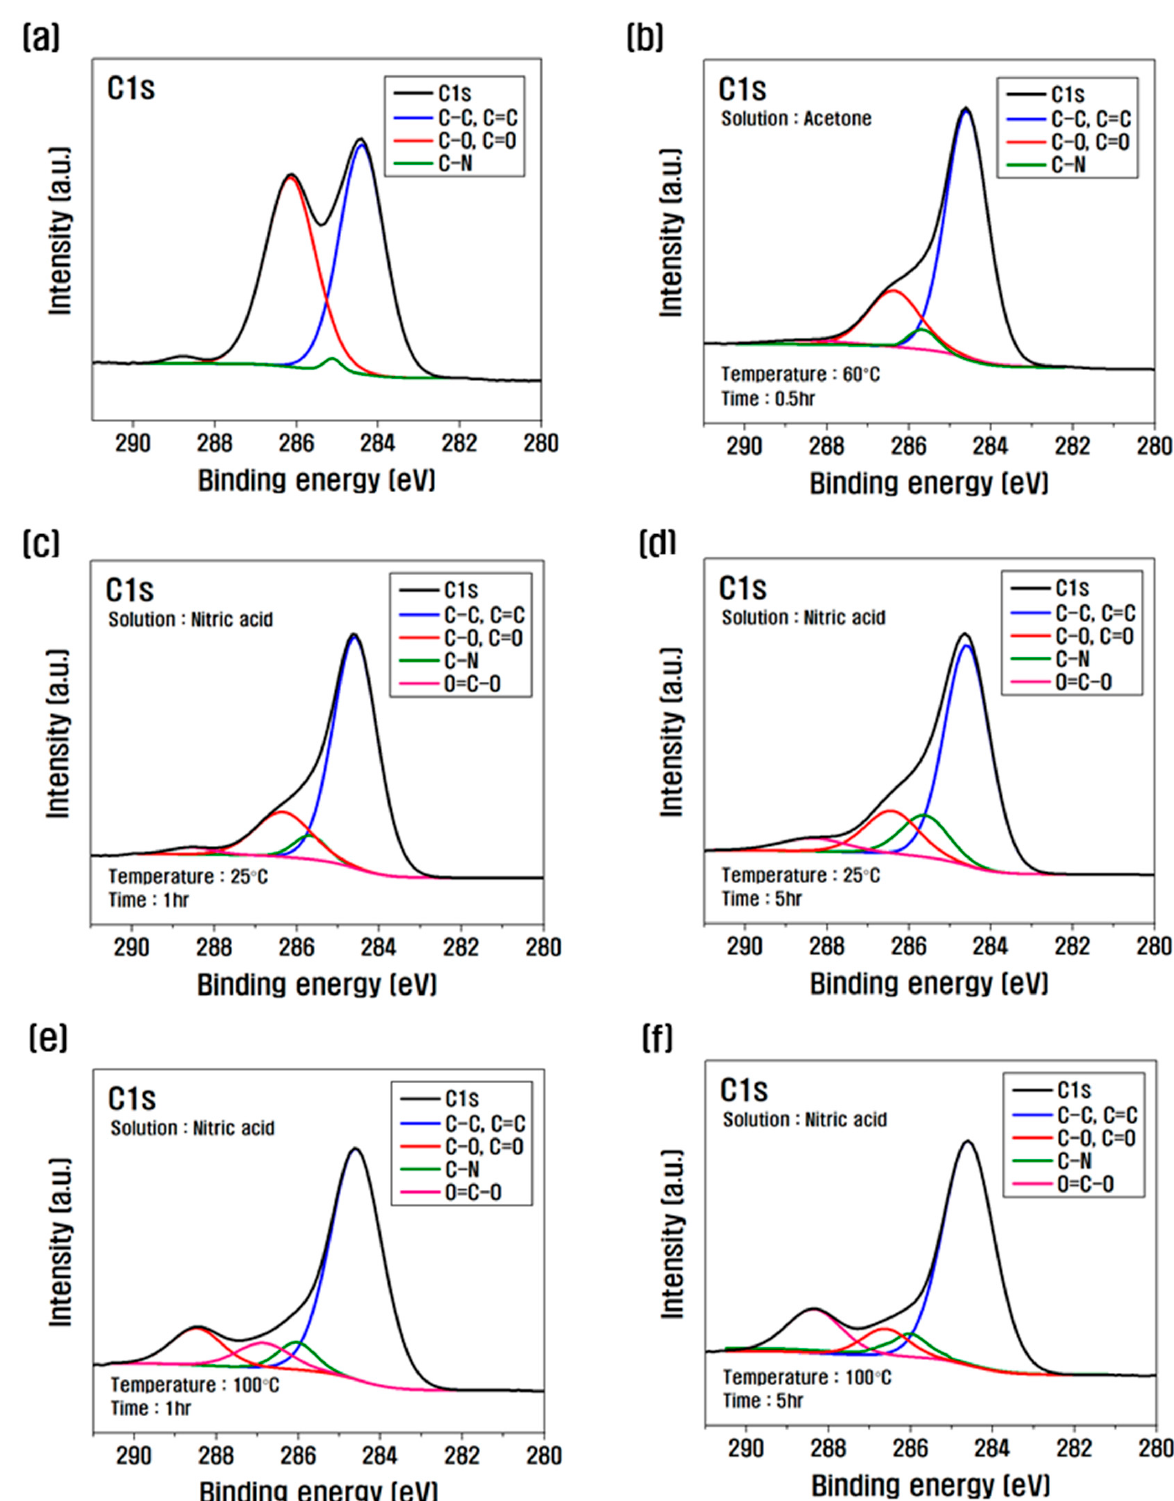
Figure 4. XPS photoelectron spectra of C1s after chemical treatment: ( a ) untreated CF, ( b ) desized CF ( c ) 1 h, ( d ) 5 h at 25 °C and ( e ) 1 h, ( f ) 5 h at 100 °C. Table 3. Functional group according to temperature and treatment time by XPS.